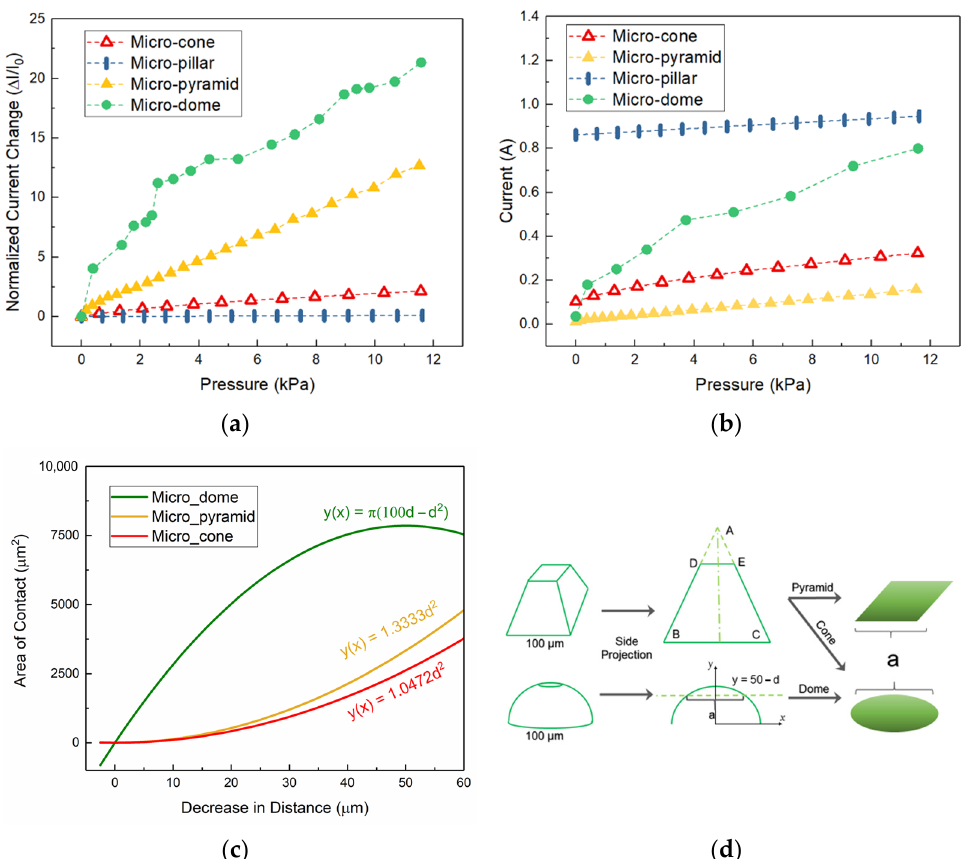
Figure 2. Simulation results for three dimensional pressure sensor. ( a ) Change in relative current as a function of normal pressure. ( b ) Passing current as a function of normal applied pressure. ( c ) Plot of area of contact between the two layers of the sensor as a function of decrease in layer spacing distance. ( d ) Schematic of a pyramid and cone that undergoes compression and dependence of contact area on decrease in inter-layer spacing distance.